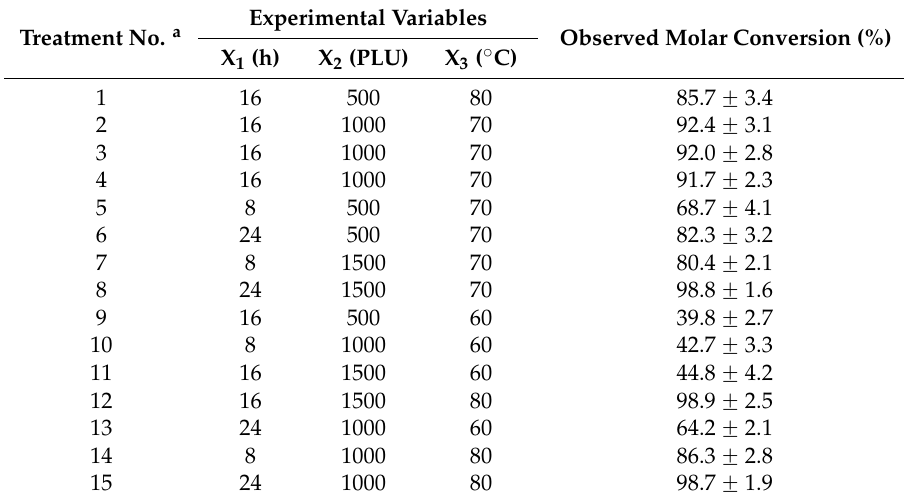
Table 1. Box-Behnken design and observed experimental data for 3-level-3-factor response surface analysis.